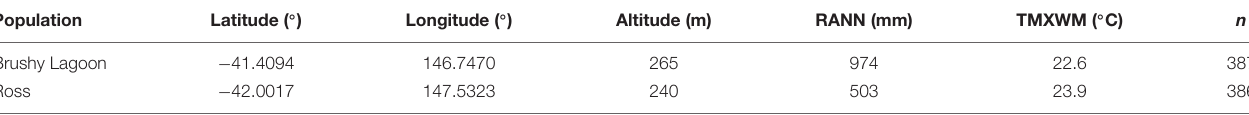
TABLE 1 | Population information for the mesic (Brushy Lagoon) and dry (Ross) populations of Eucalyptus pauciflora used in the dry-down experiment. Population Latitude ( ◦ ) Longitude ( ◦ ) Altitude (m) RANN (mm) TMXWM ( ◦